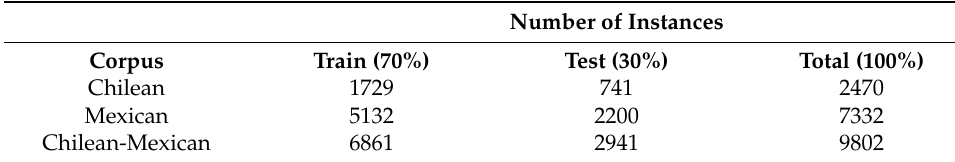
Table 3. Number of instances of training and testing of the corpus.